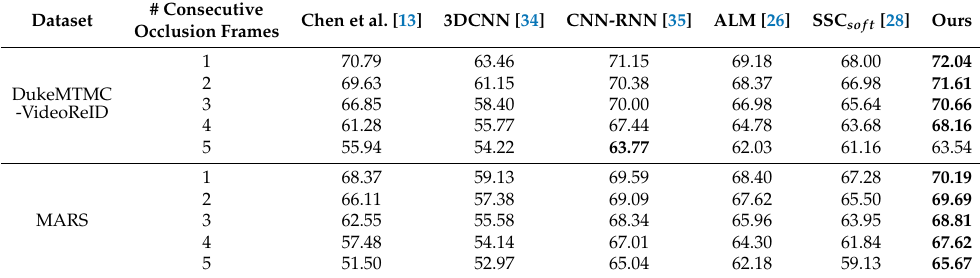
Table 7. Comparisons of the average F 1 -scores (%) for according to the number of consecutive occluded frames on the bottom occlusion scenario of the DukeMTMC-VideoReID and MARS datasets. The bold indicates the best